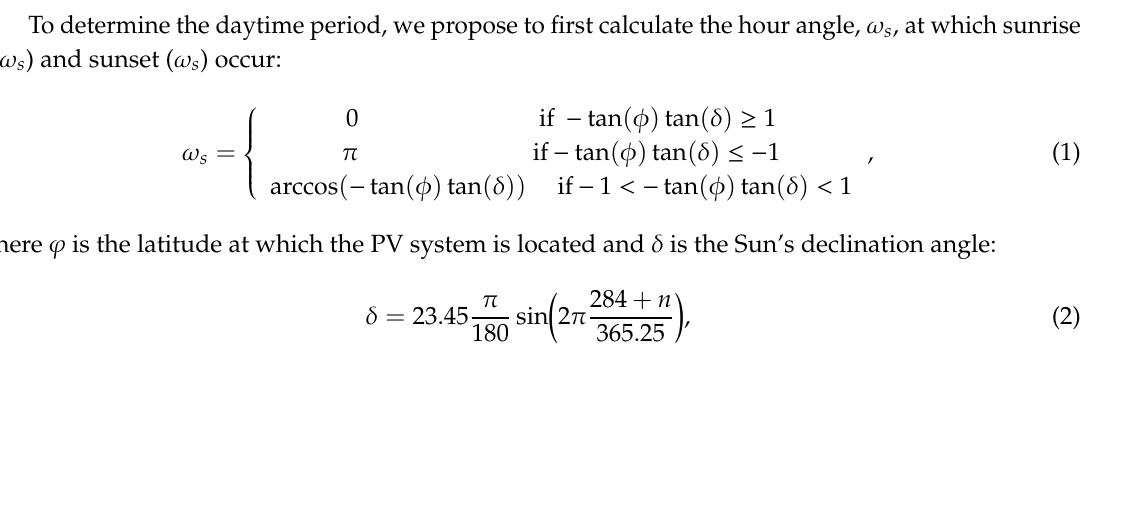
Figure 1. Overview of the algorithms for anomaly detection. ( A ) Daytime zero-production algorithm; ( B ) low maximum production algorithm; ( C ) daytime shading algorithm; ( D ) sunrise/sunset shading algorithm; and ( E ) suboptimal orientation algorithm.